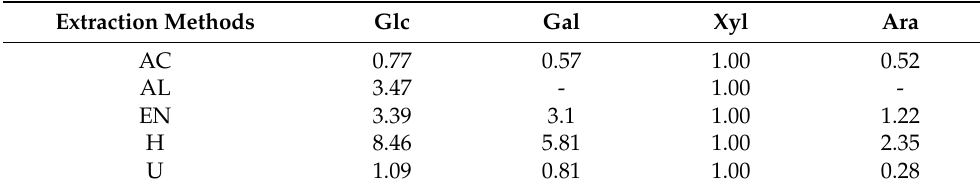
Table 3. Molar ratio of monosaccharide components of Sanchi flower soluble dietary fiber extracted by different